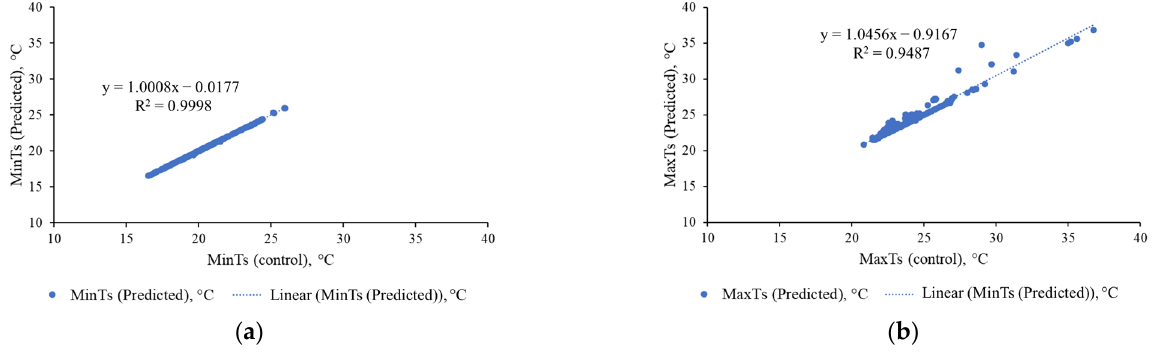
Figure 17. Comparative analysis of leaf/canopy temperature monitoring: ( a ) minimum temperature, thermal RGB; ( b ) maximum temperature, thermal RGB.